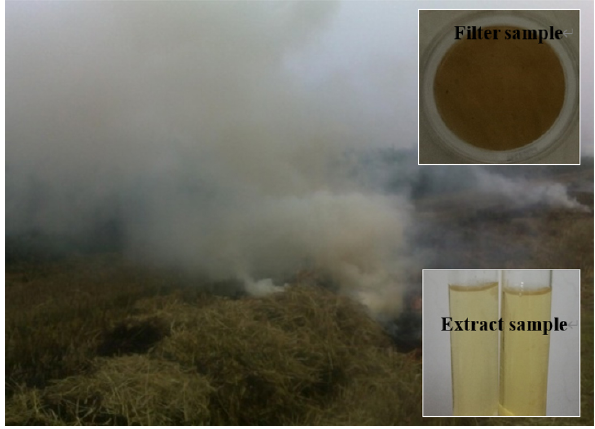
Figure 1. One field site at Daming, Hebei province, China, for sam- pling the aerosols affected by biomass